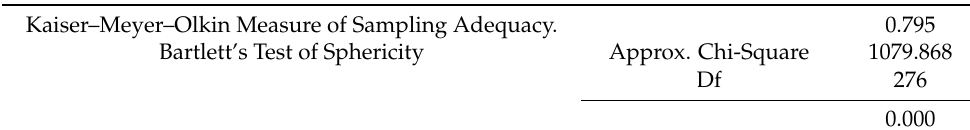
Table 2. KMO and Bartlett’s Test.